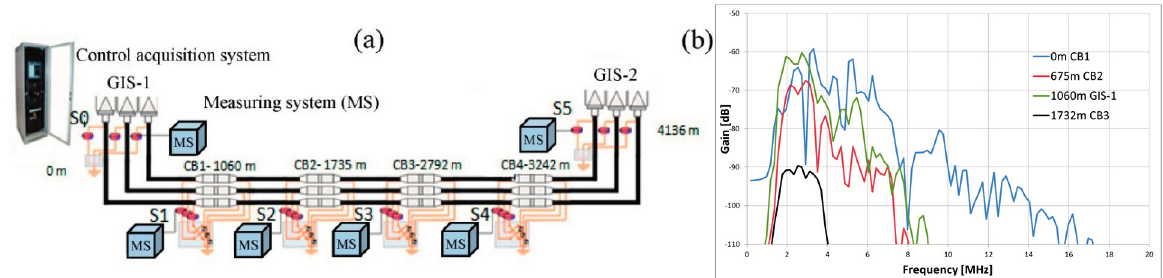
Figure 2. ( a ) On-line PD measurement with a monitoring application in a 45 kV XLPE power cable system; ( b ) Frequency spectrum of a PD pulse measured in different positions.